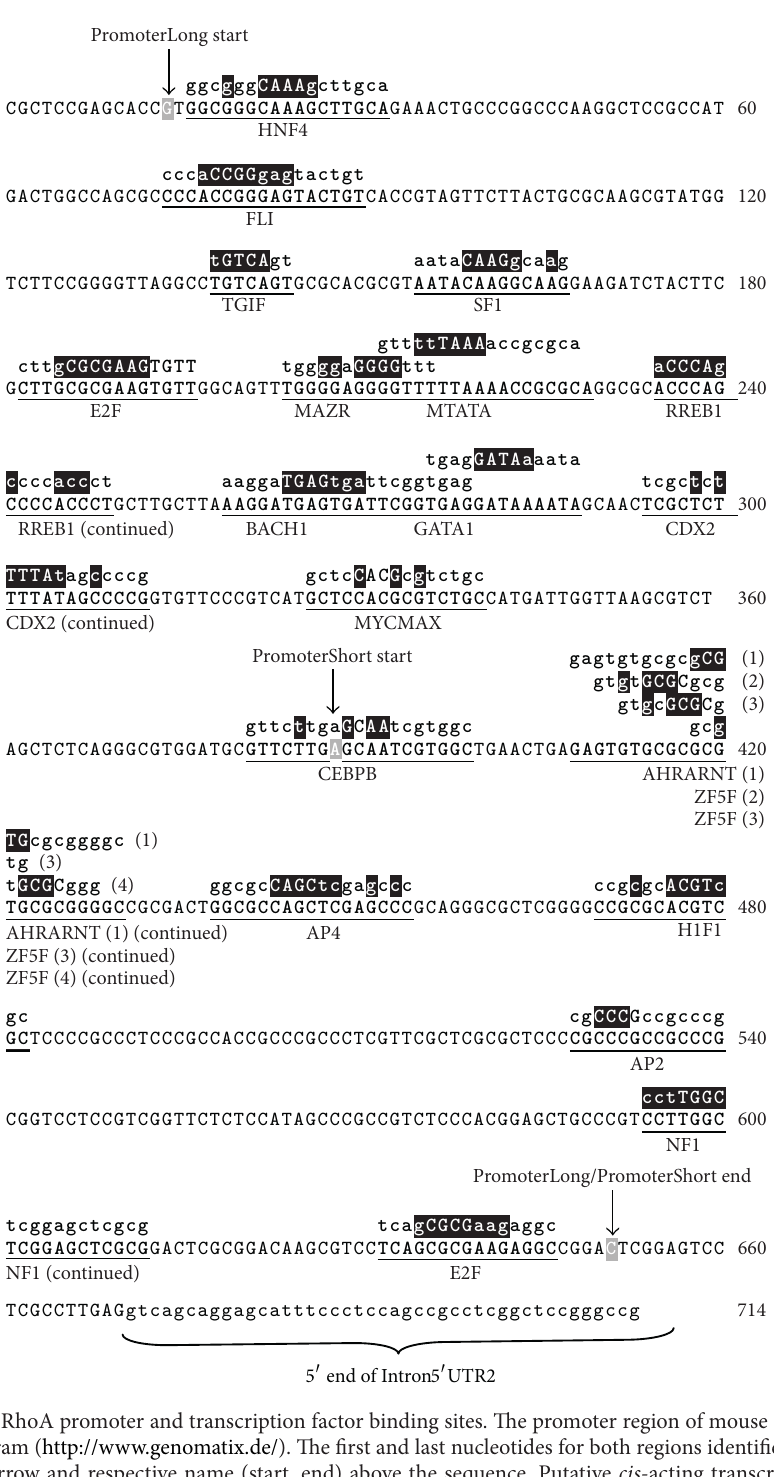
Figure 2: Putative mouse RhoA promoter and transcription factor binding sites. The promoter region of mouse RhoA was predicted using the Gene2 promoter program (http://www.genomatix.de/). The first and last nucleotides for both regions identified are in grey-boxed white text and depicted by an arrow and respective name (start, end) above the sequence. Putative cis -acting transcription factor binding sites (identified by MatInspector with a core similarity of 1 and matrix similarity above 0.8) are labelled and underlined. The nucleotides boxed in black above the consensus sequence indicate that the matrix exhibits high sequence consensus at this particular position; the nucleotides in capital letters denote the core sequence. The nucleotide numbering shown in this figure is arbitrary—the “C” nt shown at the end of the PromoterLong/PromoterShort sequences is 5 󸀠 of Intron5 󸀠 UTR2 and corresponds to nt − 94 of the mouse RhoA cDNA, where the “A” of the start ATG is designated nt